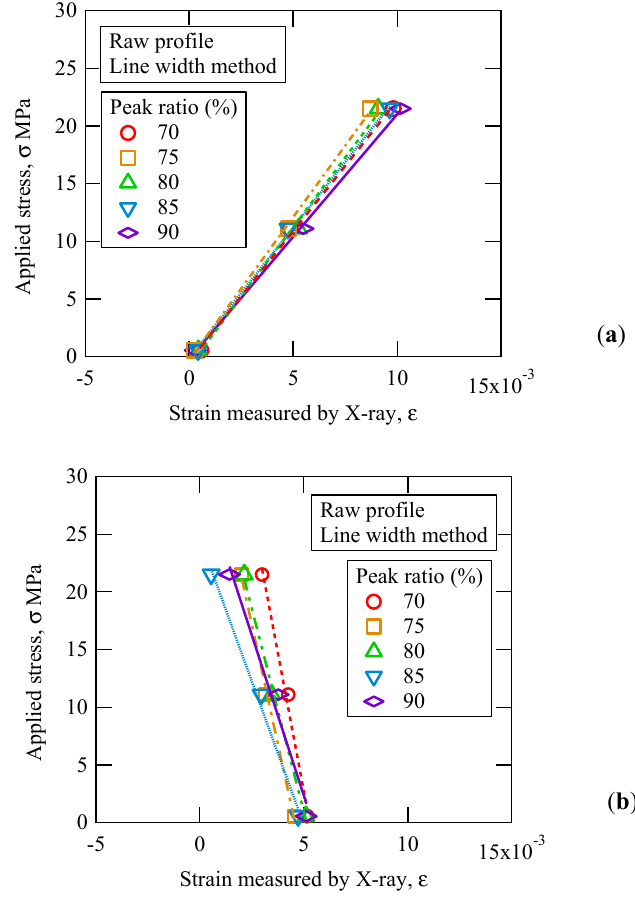
Figure 10. Relation between applied stress and strain measured by X-ray for diffraction line width method: ( a ) Longitudinal strain; ( b ) Transverse strain.